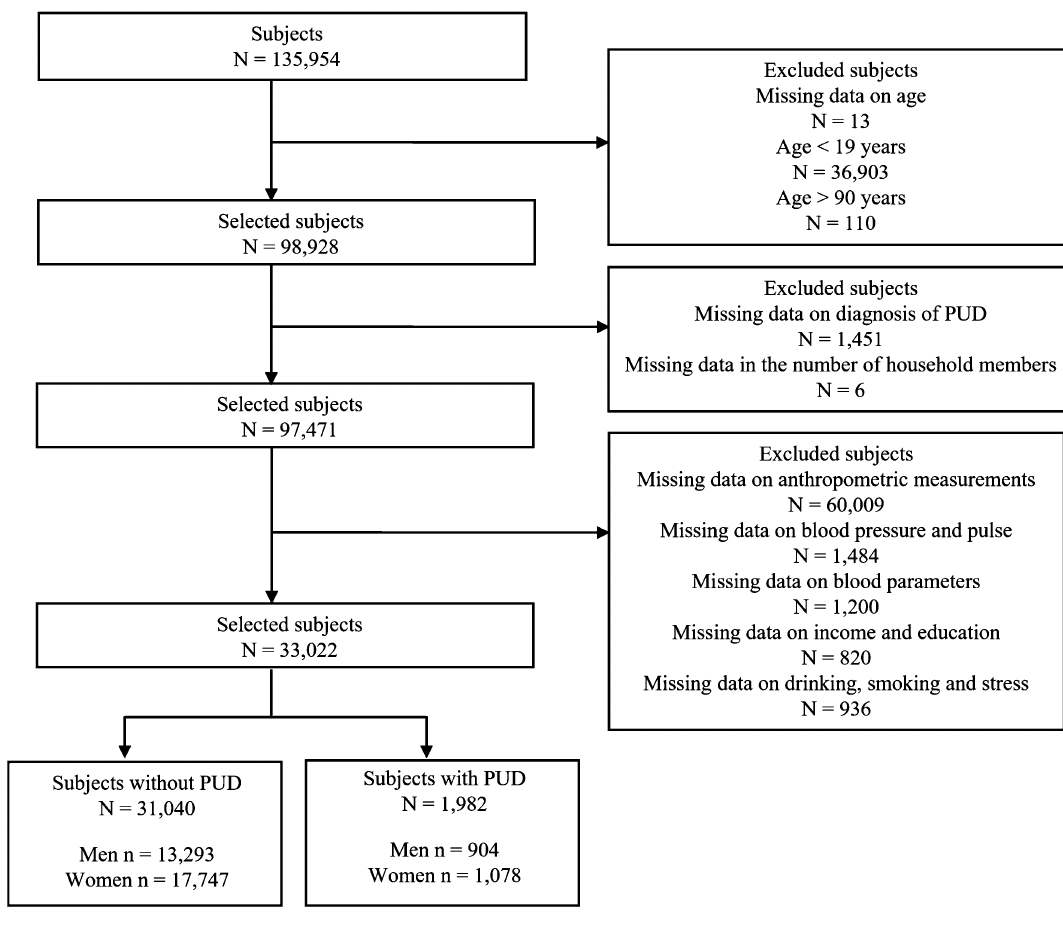
Figure 1. Sample selection flow. PUD: peptic ulcer